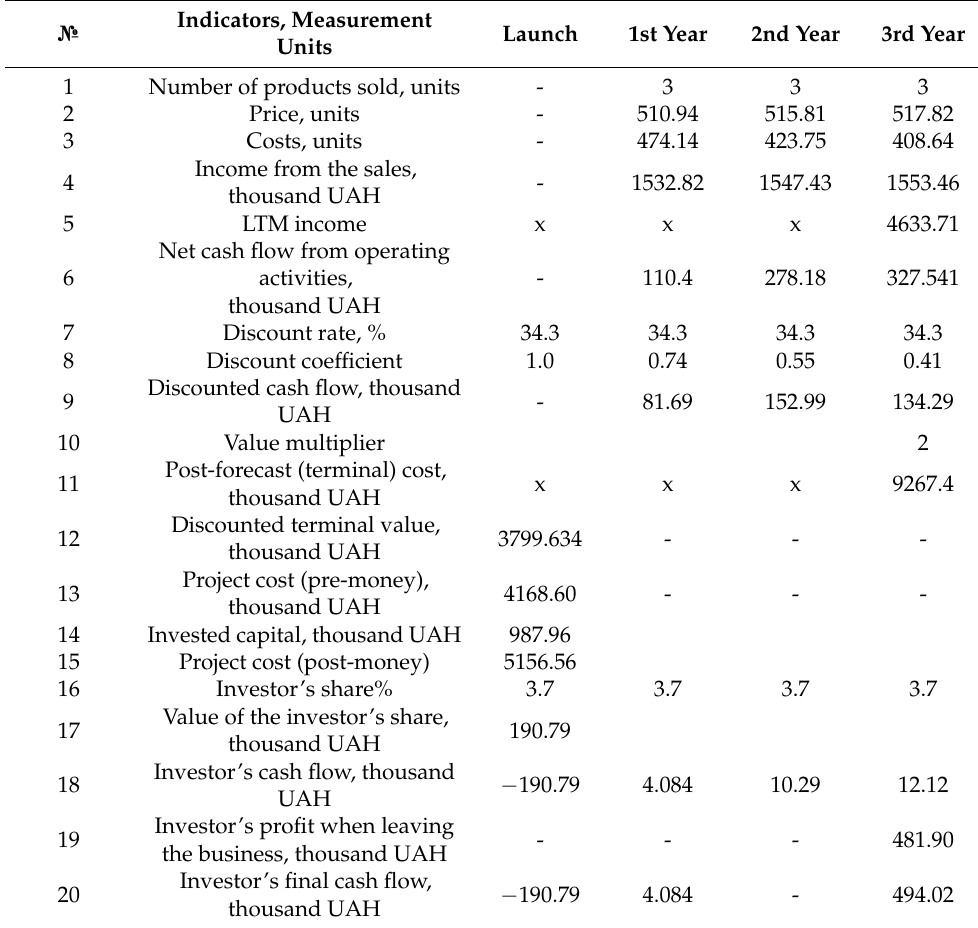
Table 8. Economic indicators of the project of the commercialization of the device of the interferomet- ric determination of the refractive index of crystalline materials in the optical range, determined by the income methodological approach 1